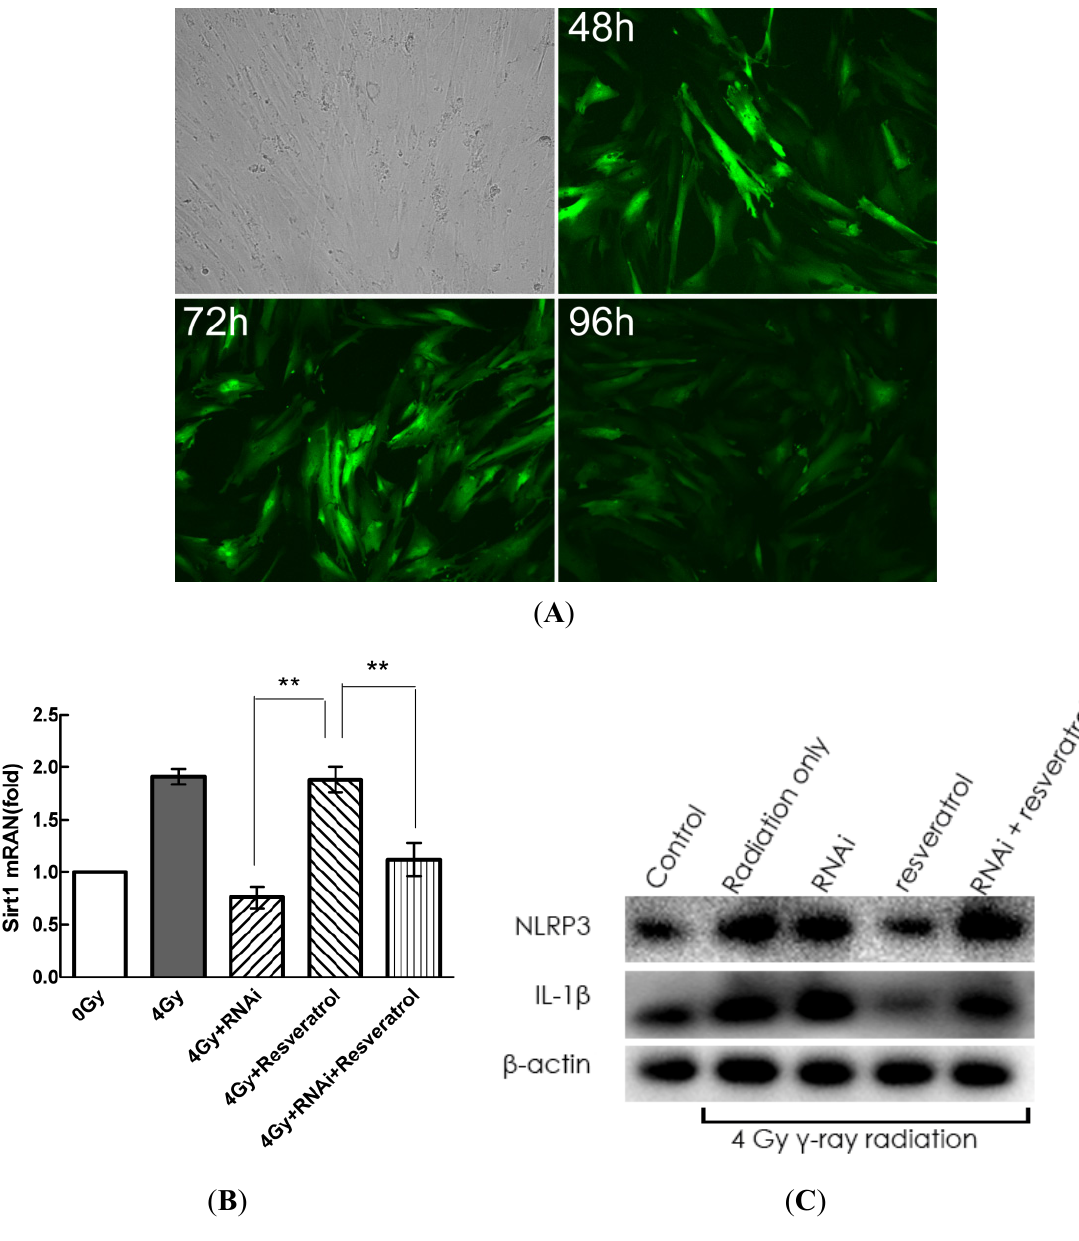
Figure 5. The knockdown of Sirt1 by shRNA suppresses resveratrol-mediated anti-inflammatory activity. ( A ) Cells were transfected with Sirt1 shRNA for 48, 72, or 96 h; ( B ) Sirt1 expression was down-regulated by Sirt1 shRNA. The cells were transfected with Sirt1 shRNA for 48 h, and mRNA expression of Sirt1 was then determined by quantitative real-time PCR; ( C – E ) The knockdown of Sirt1 obviously suppresses resveratrol-mediated anti-inflammatory activity, and radiation-induced IL-1 β expression was significantly increased by Sirt1 RNAi. The cells were stimulated with radiation for 24 h after transfection with Sirt1 shRNA for 48 h; protein and mRNA expressions of IL-1 β and NLRP3 were determined by Western blot and quantitative real-time PCR analyses, respectively, and IL-1 β secretion was detected by ELISAs. Values are presented as the mean ± SD ( n = 3). * p < 0.05, ** p < 0.01 compared with the resveratrol